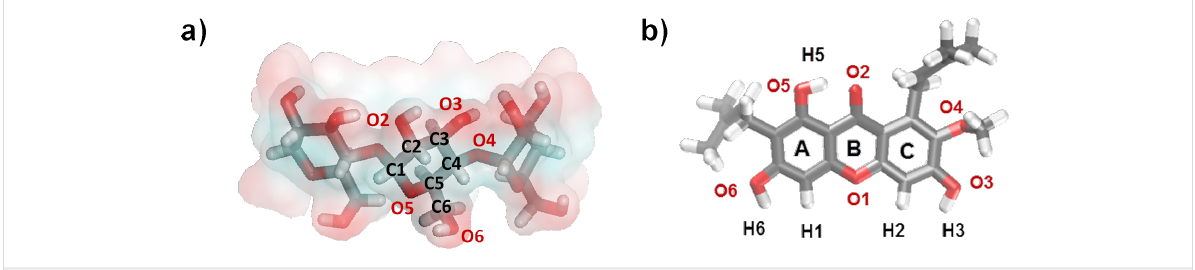
Figure 1: Schematic views of a) β -CD and b) α -mangostin ( α -MGS) geometries.